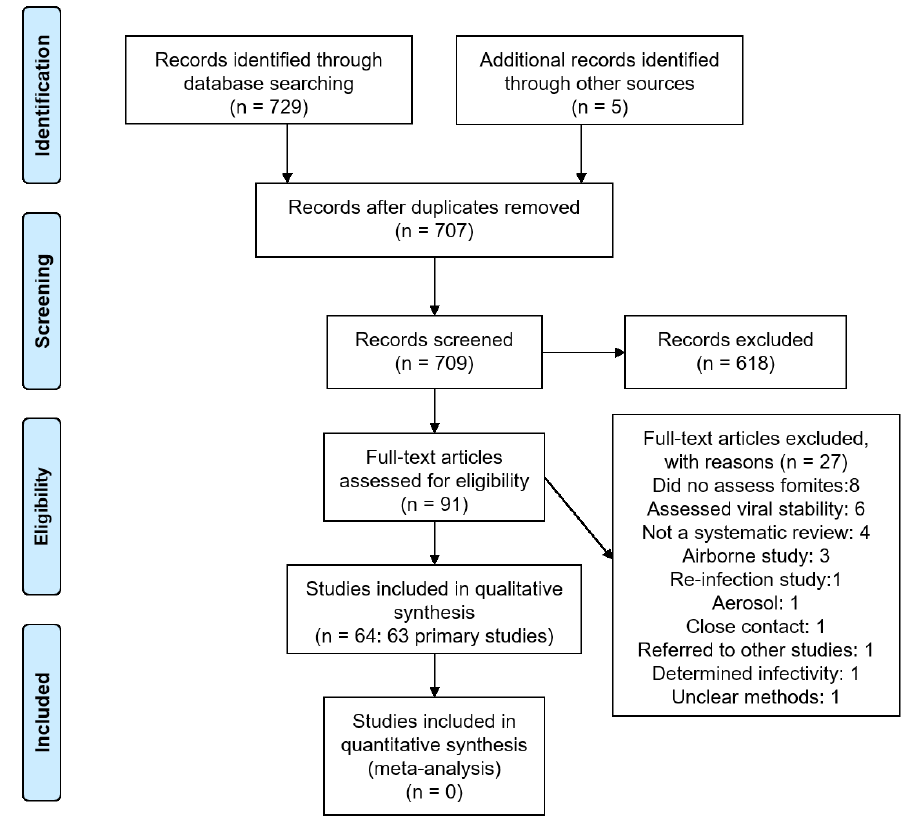
Figure 1. Flow diagram showing the process for inclusion of studies assessing fomites transmission in SARS-CoV-2.